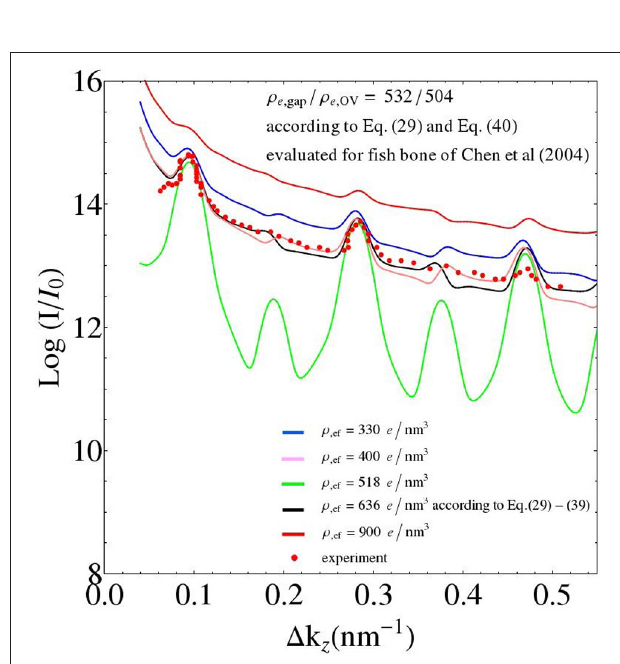
FIGURE 11 | Parameter study: changing the value of the electron density of the extrafibrillar space; while keeping the electron densities of the gap and overlap zones constant (adopting the values from the fish bone simulation of Figure 7